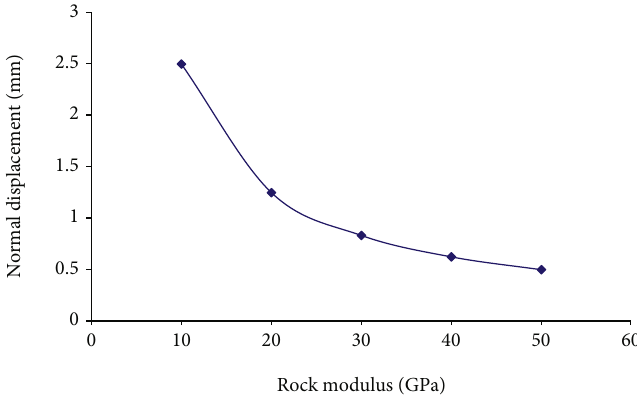
Figure 8: Relation between rock modulus and normal displacement.